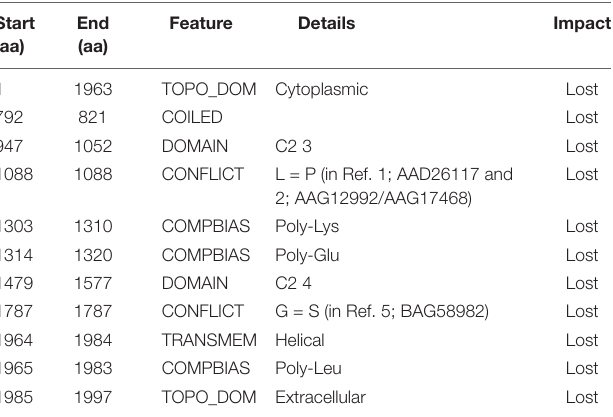
TABLE 1 | Functional evidence of the OTOF variant (NC_000002.12:g.2:26702224G > A) by in silico evaluation, using Mutation Taster. Start